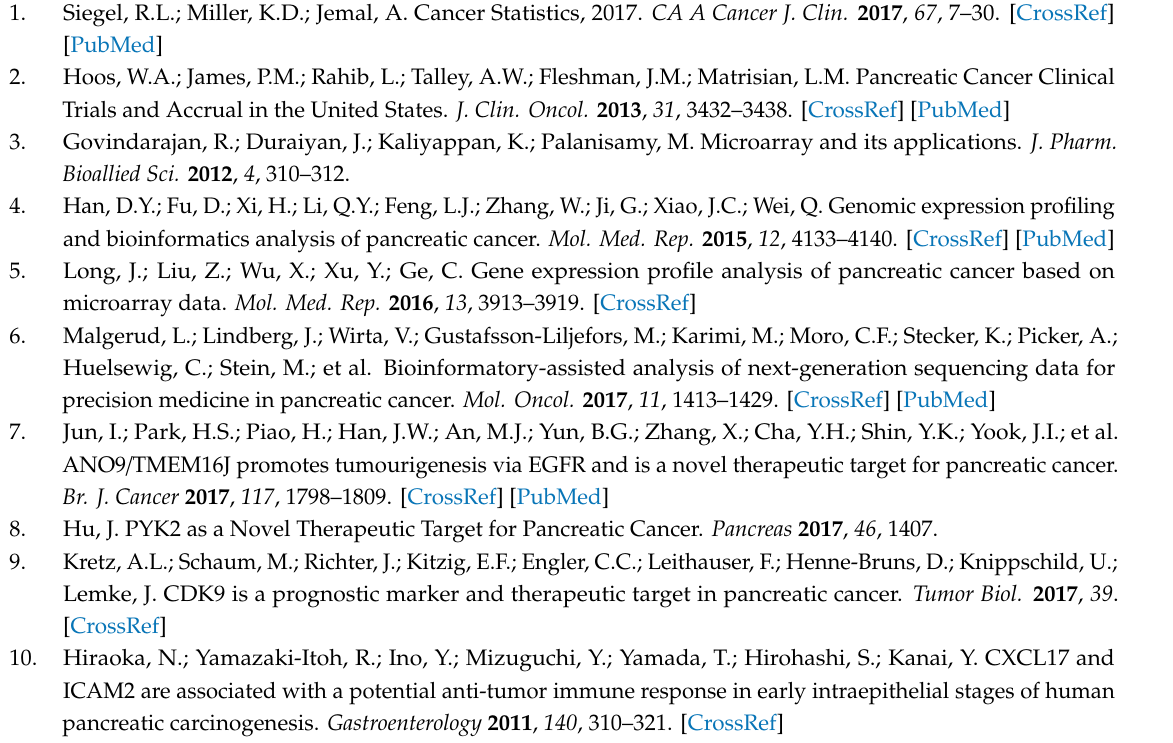
Figure S1: hierarchical clustering with limiting the analysis only to the 138 common DEGs. The row denotes the genes, the column denotes the samples, A : GSE15471, B : GSE19650, C : GSE32676, D : GSE71989, Table S1: Analysis gene ontology and KEGG pathway by KOBAS 3.0; Table S2: Definition of 12 topological